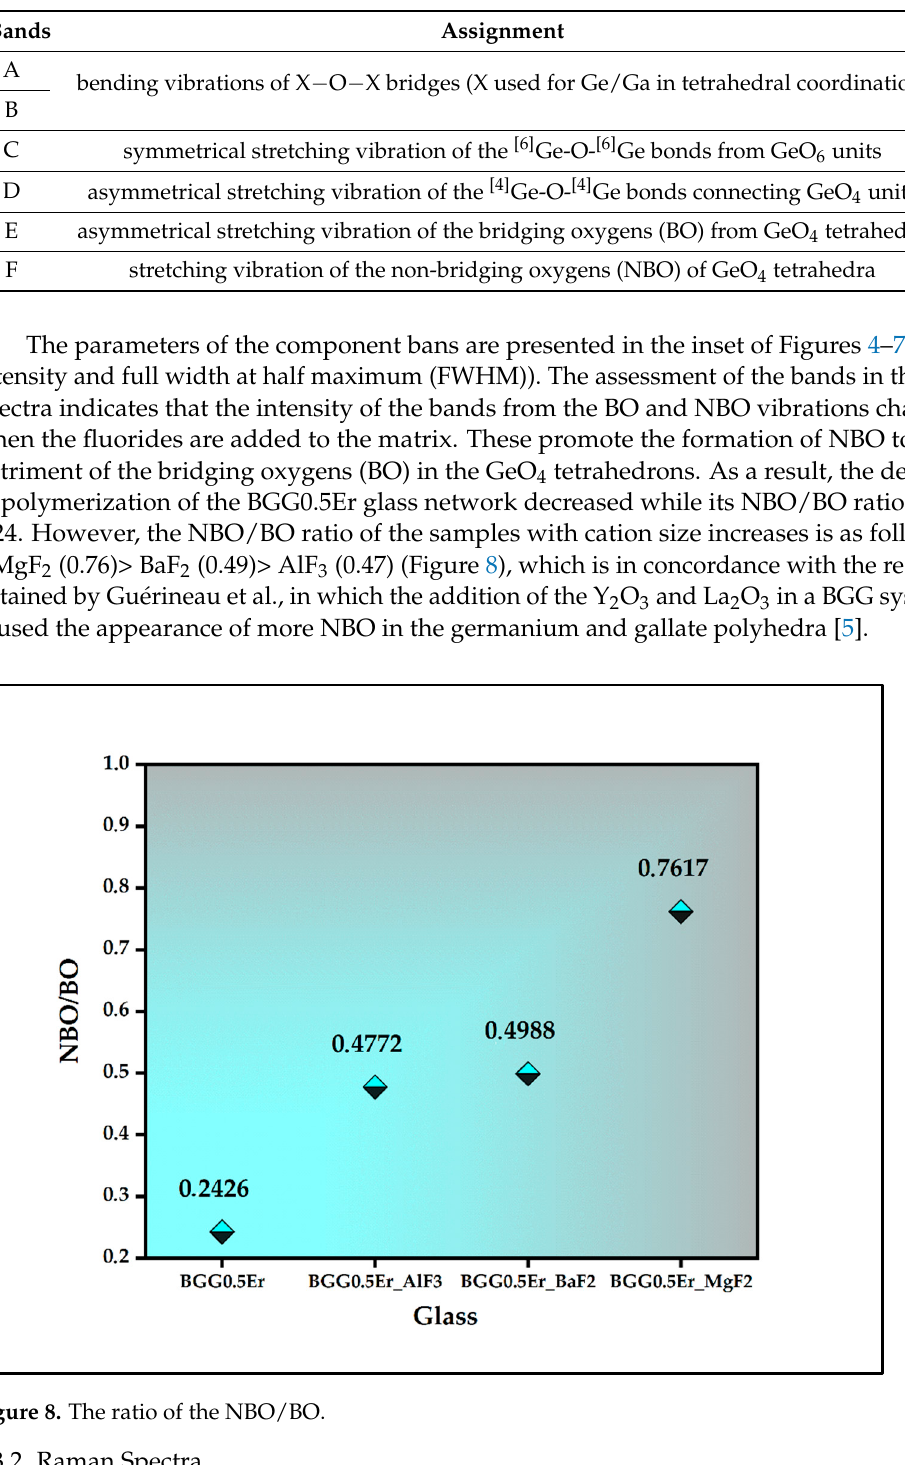
Table 2. Assignment of the IR bands.